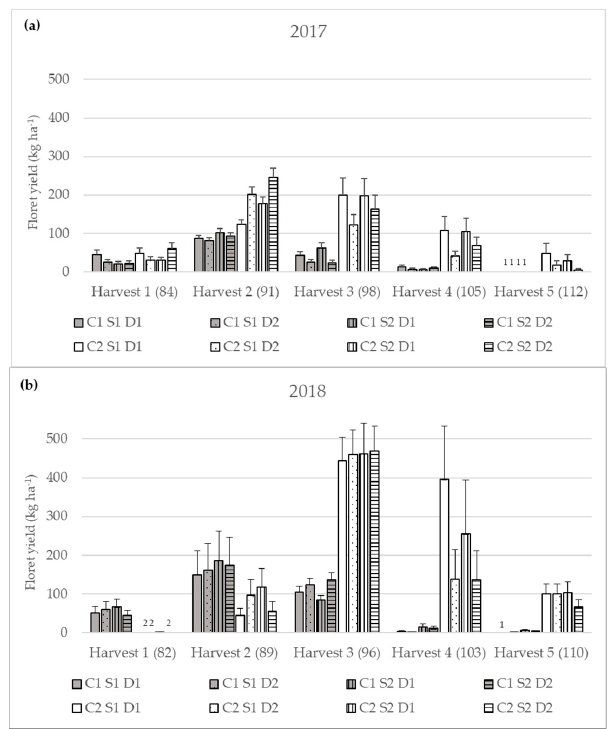
Figure 3. Yield of flowering florets (kg ha − 1 ) for the two years (( a ) 2017 and ( b ) 2018) and the eight different treatments (German and Chinese cultivar (C1 and C2), row spacing of 12 and 33 cm (S1 and S2), and sowing densities of 40 and 75 plants m − 2 (D1 and D2) of the five harvests (Harvest 1–5) (DAS, days after sowing) represented as mean values ± standard error. Table 6. ANOVA table of the significant terms and interactions in yield of flowering florets. ANOVA Table of the Significant Terms and Interactions Model term Degree of Freedom p -value 1 Harvest date * Cultivar * Row spacing